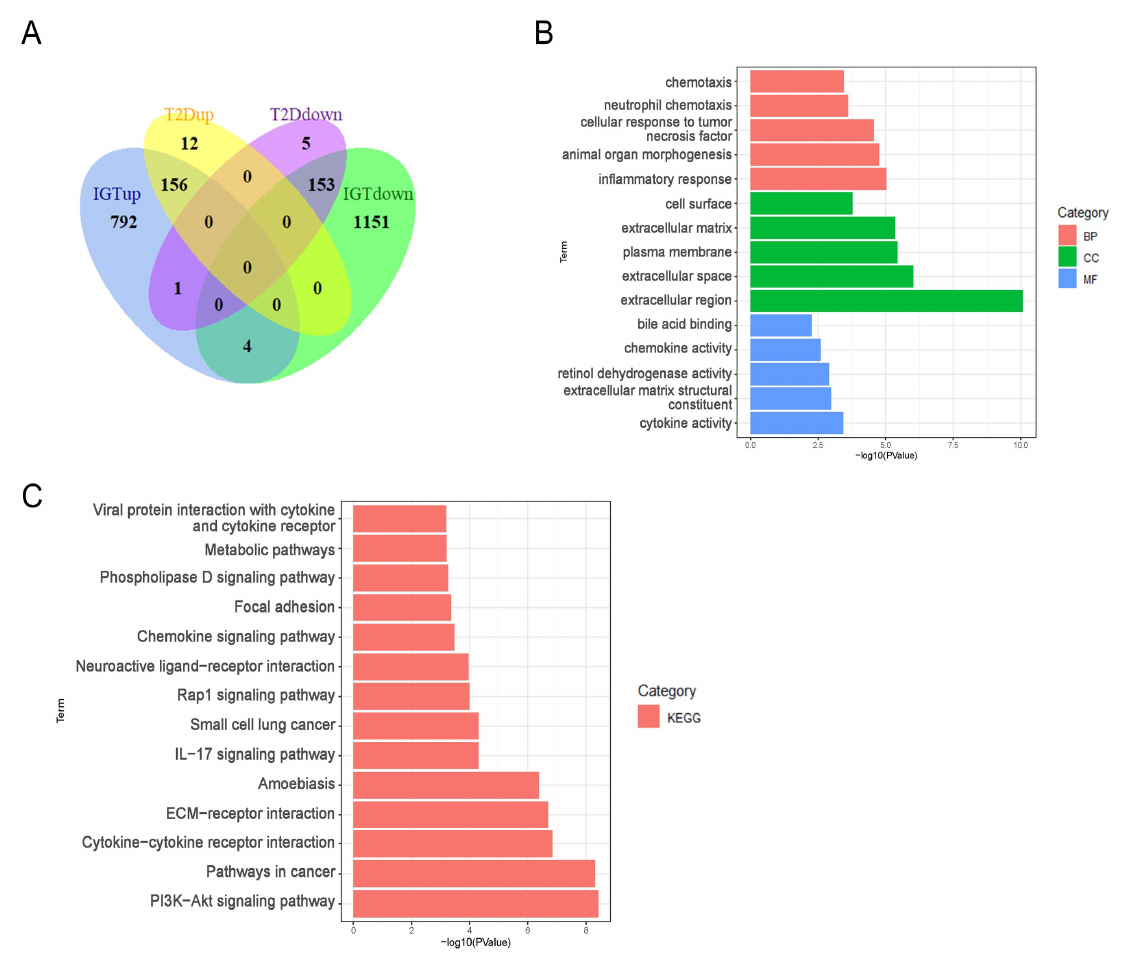
Figure 2. The results of Co ‐ DEGs ( A ); GO of Co ‐ DEGs ( B ); and KEGG of Co ‐ DEGs ( C ).